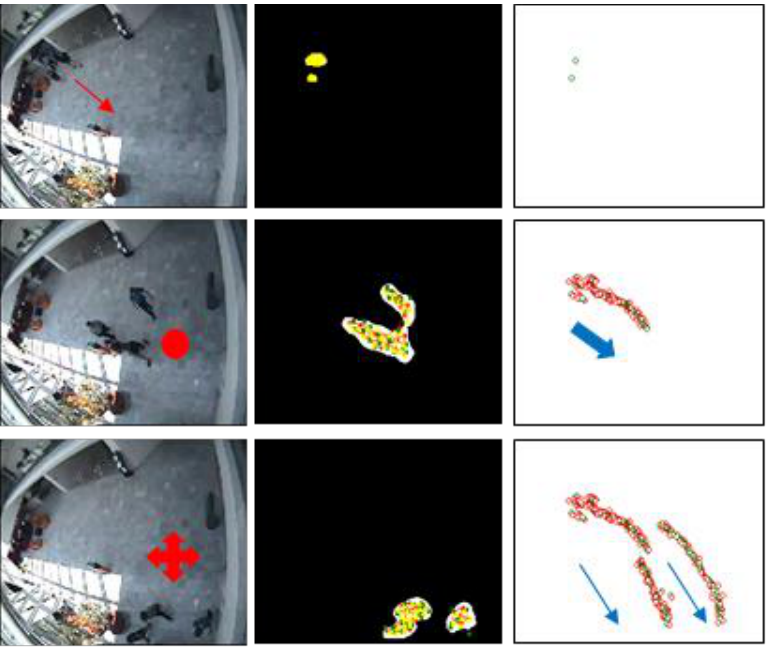
Figure 7. Example of a single-image multi-target visual surveillance system.